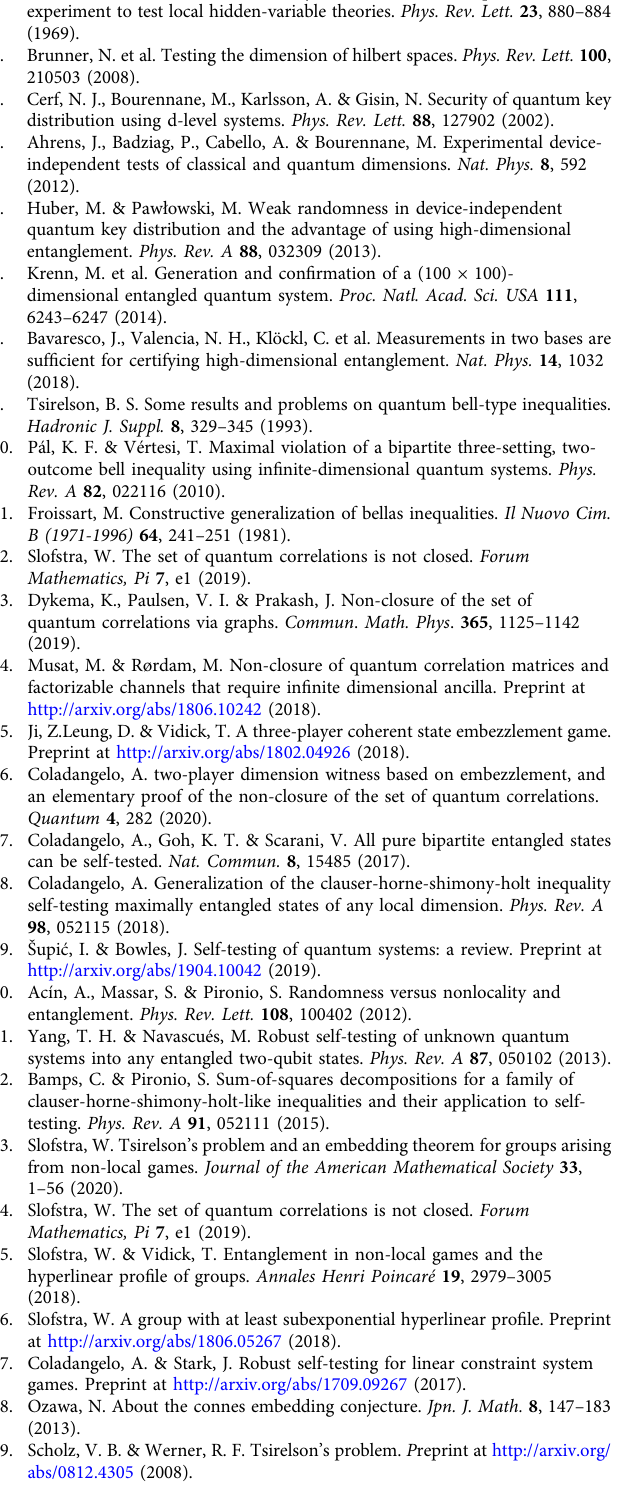
Table 5 T xy for x = 2, y =